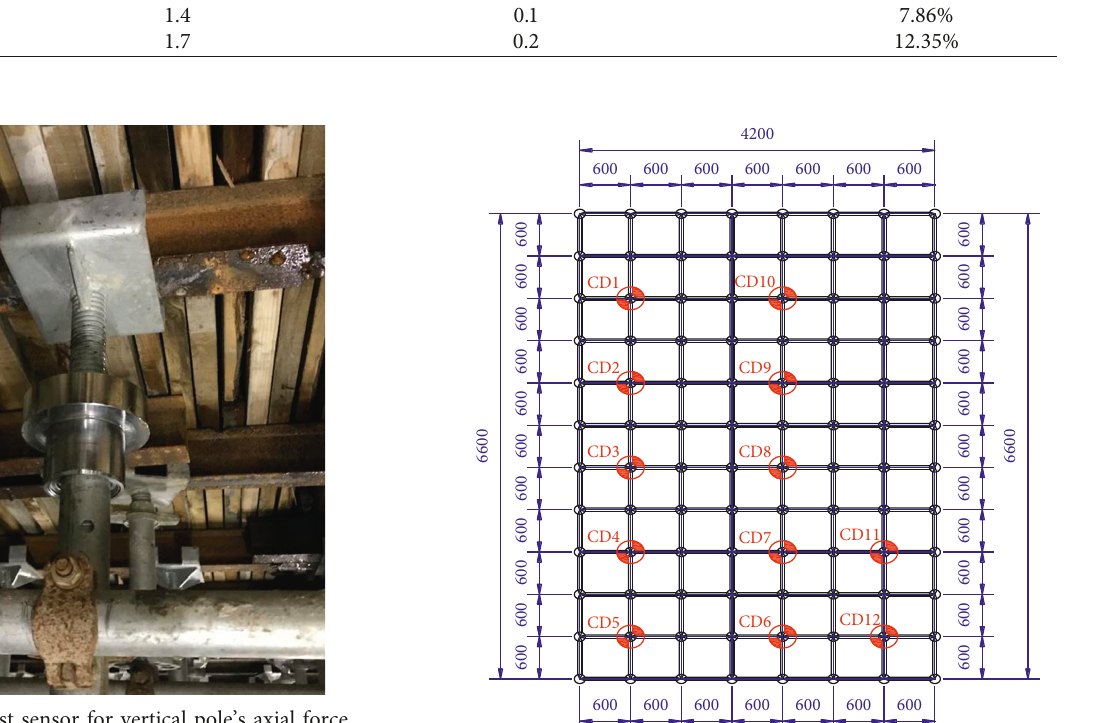
Table 2: Mathematical statistics of increasing coefficient of pole’s axial force under different gap intervals. gap interval